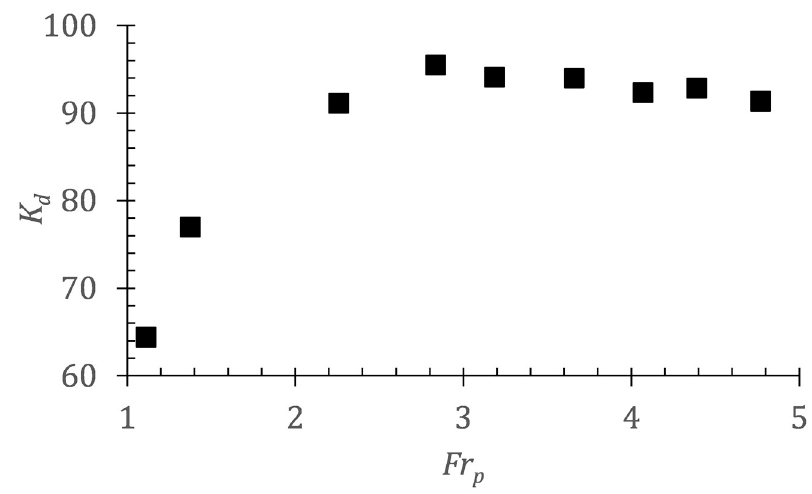
Figure 19. Momentum flux dissipation rate of jets vs Fr p.